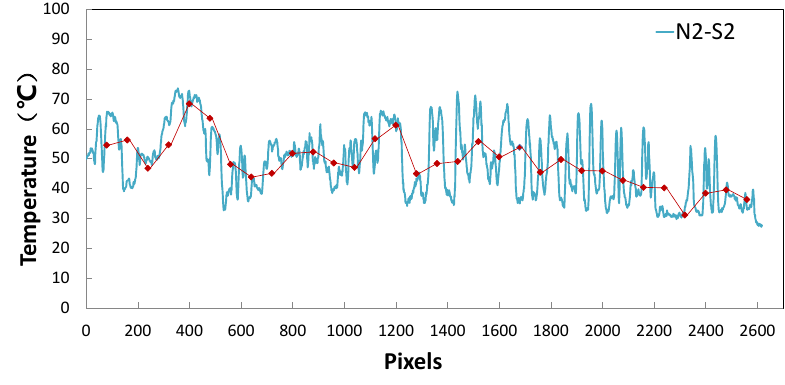
Figure 13. LST on profiles N2–S2 (Lines marked in Figure 9): The resolution of N2–S2 and LST-AVG 60 are 0.8 m and 60 m,